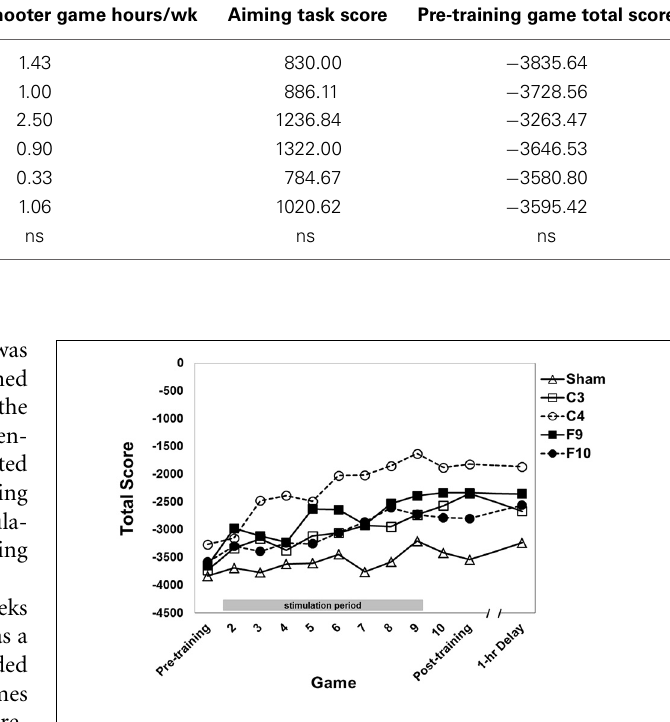
FIGURE 4 | Total score (sum of 4 subscores) for each stimulation group across 12 games with varying instructional emphasis. Pre-training, Post-training and 1-hr Delay games were all “total emphasis” games. The training block consisted of Games 2 through 10. Game 2 was “control score” emphasis, Game 3 was “velocity score” emphasis, Game 4 was “speed score” emphasis, Game 5 was “points score” emphasis and Games 6–10 were “total score” emphasis. The 1-hr delay game began 1hour after the end of the post-training game. Timed stimulation started prior to Game 2 and ended during Game 9 (gray bar). Standard errors are listed separately in Table 2